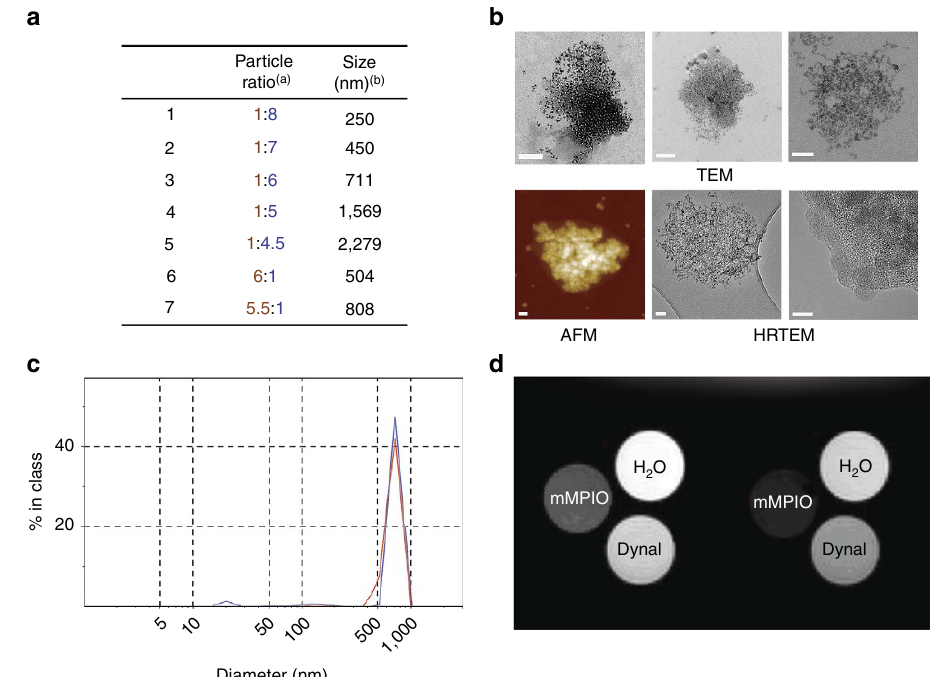
Figure 3 | Physicochemical characterization of mMPIO. ( a ) Size and yield of mMPIO as a function of carboxy-NP/peptido-NP ratio. [a] Ratio between carboxy-NPs and peptido-NPs (w/w). [b] Determined by dynamic light scattering (DLS). ( b ) Microscopic characterization of mMPIO by TEM (top three images showing different representative examples; scale bars left-to-right 100, 100 and 50nm), atomic force microscopy (bottom left, scale bar 50nm) and HRTEM (bottom middle and right; bottom right is the inset magnification from bottom middle; scale bars 50 and 5nm). ( c ) DLS size distribution graph of B 700nm mMPIO just after synthesis (red line) and after storage for 6 months (blue line). ( d ) T 2 -weighted images of the phantoms (iron concentration ¼ 0.224mM) at echo times 9.7ms (left) and 16.3ms